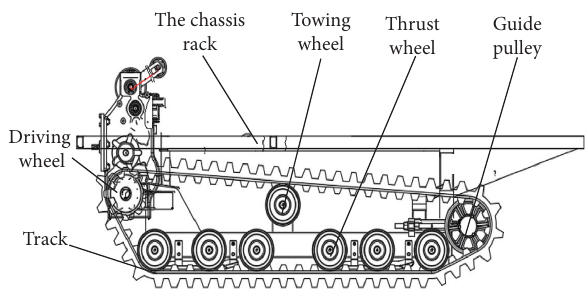
Figure 2: Structure of the “four wheels and one